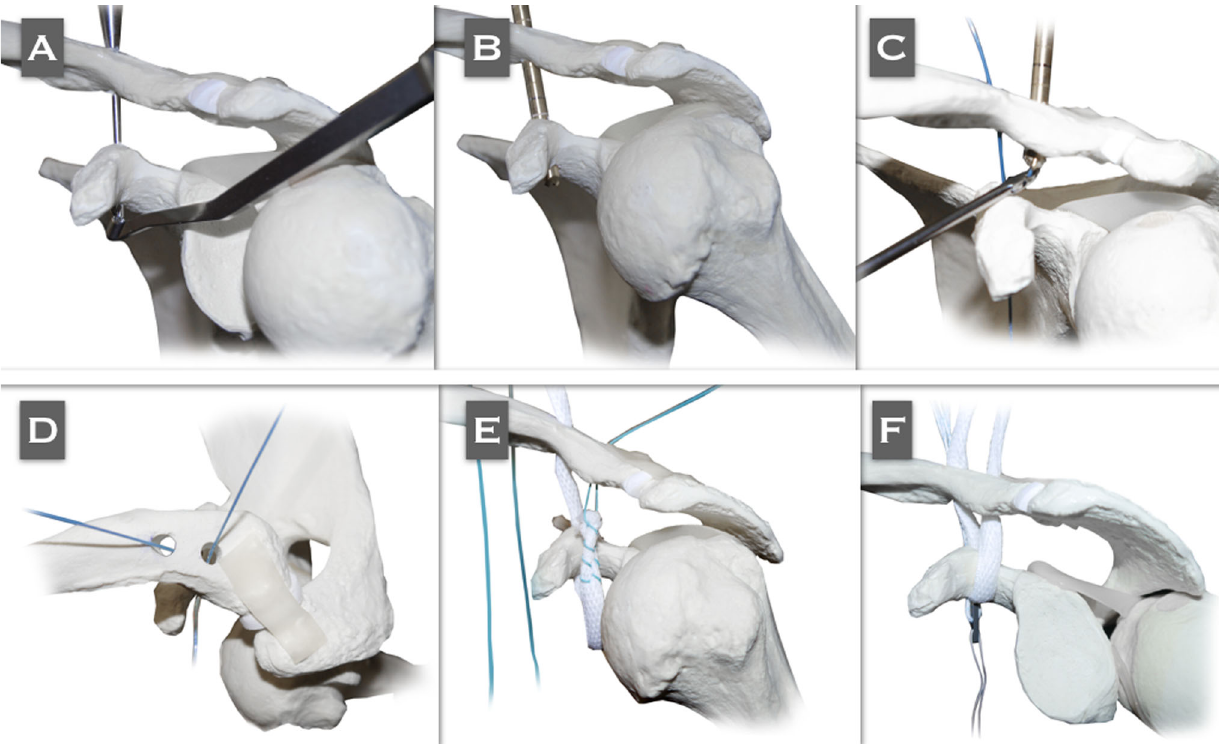
Fig. 4 Reproduced with permission and copyright (cid:2) of Arthroscopy Techniques, Elsevier. a The AC drilling guide is placed at the coracoid base with the sliding tube of the guide in the superior aspect of the clavicle, 4.5 cm medial to its lateral border (conoid native origin). A 2.4-mm K-wire is passed through the AC guide. b A cannulated 4.5- to 6-mm (depending on the graft diameter) drill is passed over the K-wire and comes out from the inferior aspect of the coracoid. c A shuttle 1-mm PDS suture is passed through the cannulated drill located in the trapezoid tunnel. The PDS is